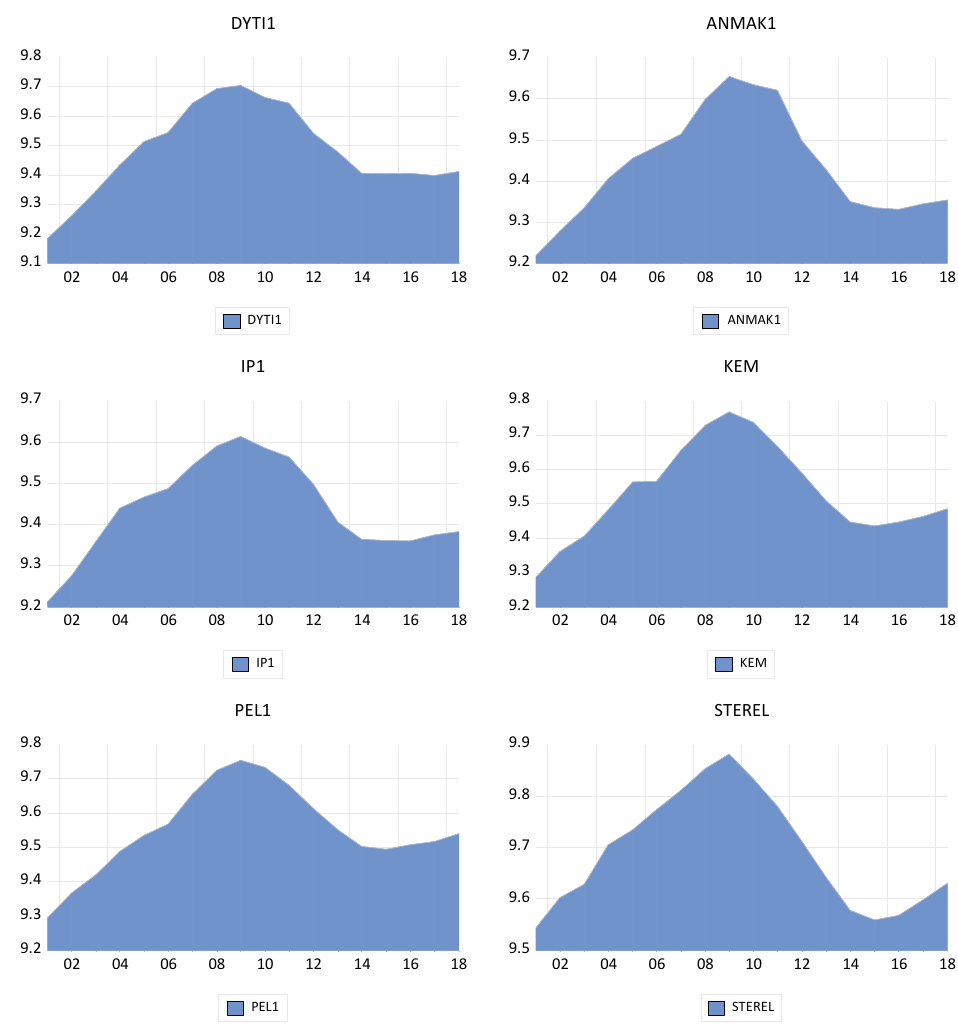
Figure 2. The evolution of GDP per capita generated by energy and mining in a logarithmic form for all the peripheries in Greece in the years 2000–2018 (Source NSI own calculation).